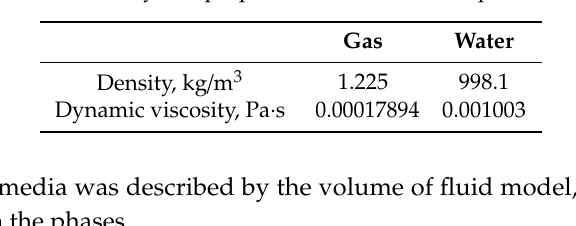
Table 2. Physical properties of the simulated phases.